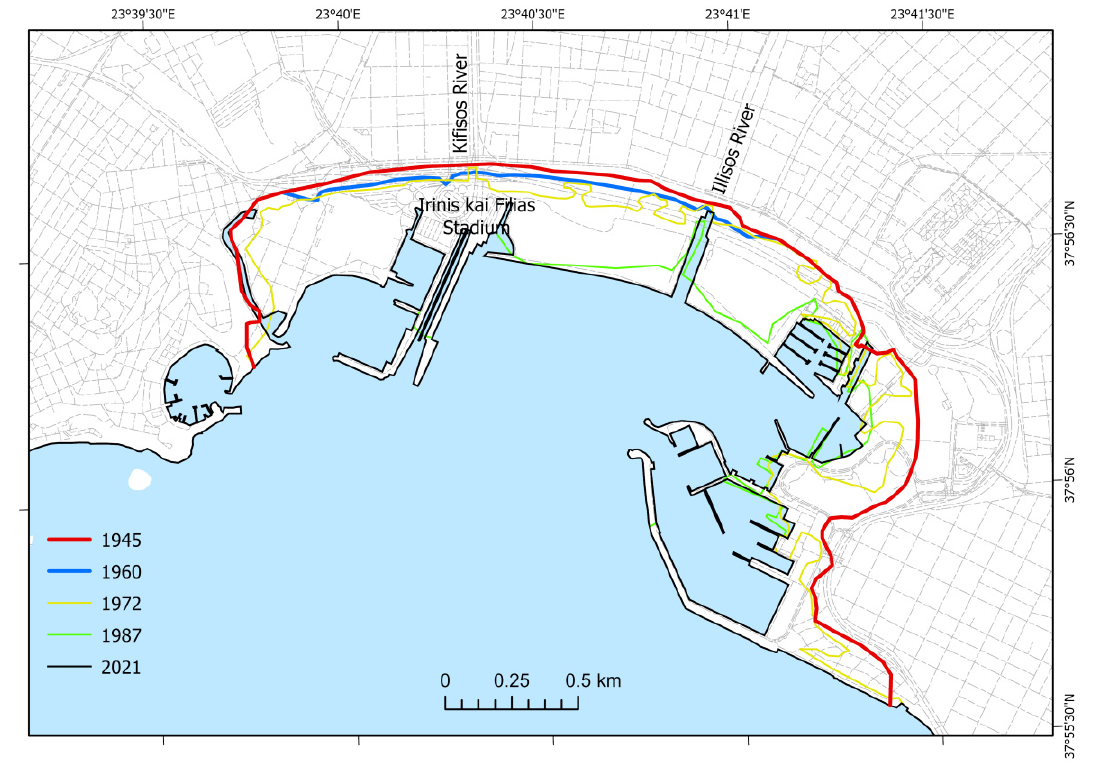
Figure 4. Changes of the Faliro coastline from 1945 to Figure 4. Classification of the coastline based on 2021 imagery and fieldwork. The north part of the study area is charac- terized as mainly artificial.